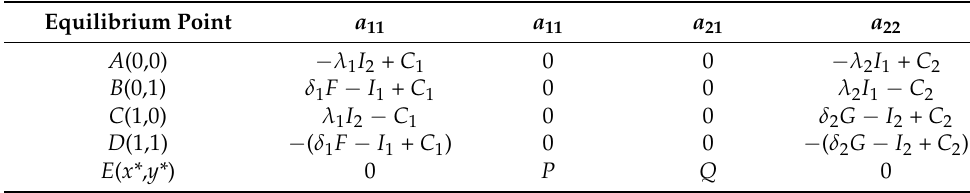
Table 3. Values at the local equilibrium point. Equilibrium